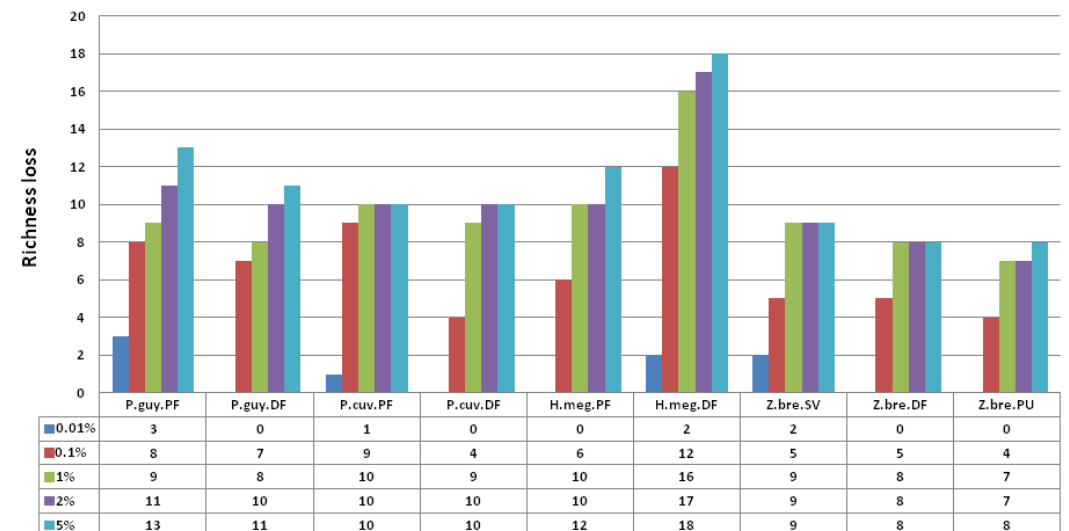
Figure 4. Bar plot of richness loss between original data set and different thresholds (minimum percent abundance) of suppressions by species–habitat combinations. Percent thresholds were 0.01, 0.1, 1, 2 and 5%. P.guy.PF: Proechimys guyannensis from pristine forest, P.guy.DF: Proechimys guyannensis from disturbed forest, P.cuv.PF: Proechimys cuvieri from pristine forest, P.cuv.DF: Proechimys cuvieri from disturbed forest, H.meg.PF: Hylaeamys megacephalus from pristine forest, H.meg.DF: Hylaeamys megacephalus from pristine forest, Z.bre.SV: Zygodontomys brevicauda from savannah, Z.bre.DF: Zygodontomys brevicauda from disturbed forest, Z.bre.PU: Zygodontomys brevicauda from peri-urban areas.